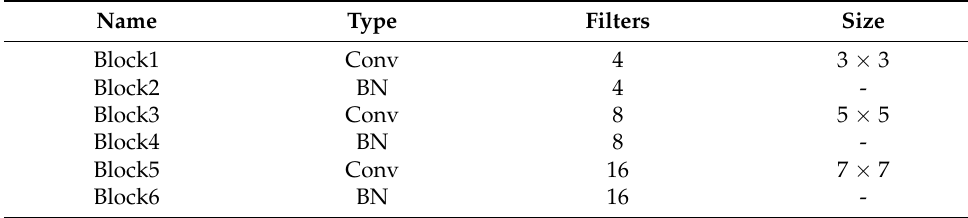
Table 1. Details of the encoder convolution layer network.